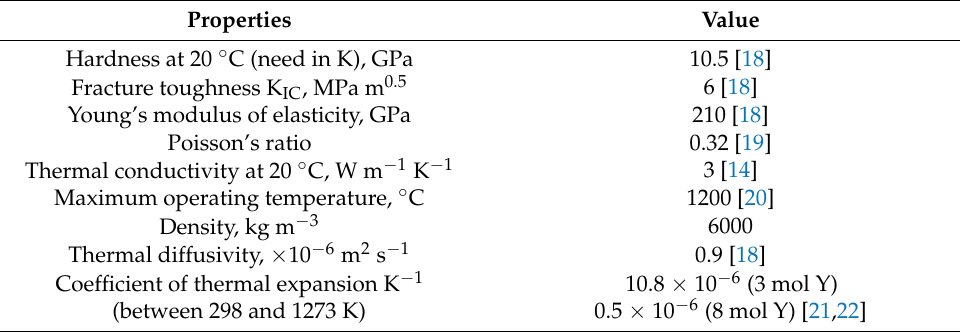
Table 1. Main properties of yttria-stabilized zirconia.